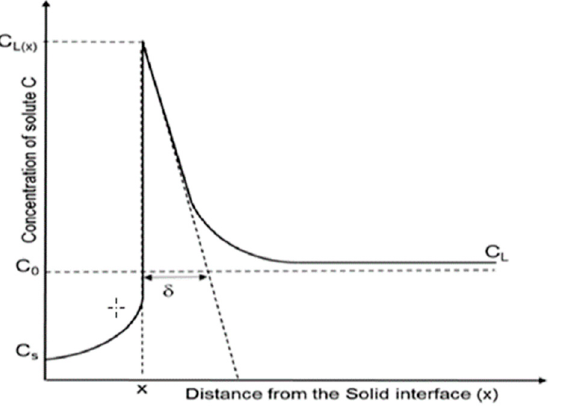
Figure 1. Depiction of the boundary layer ahead of the crystallization front, adapted from [13,14] .